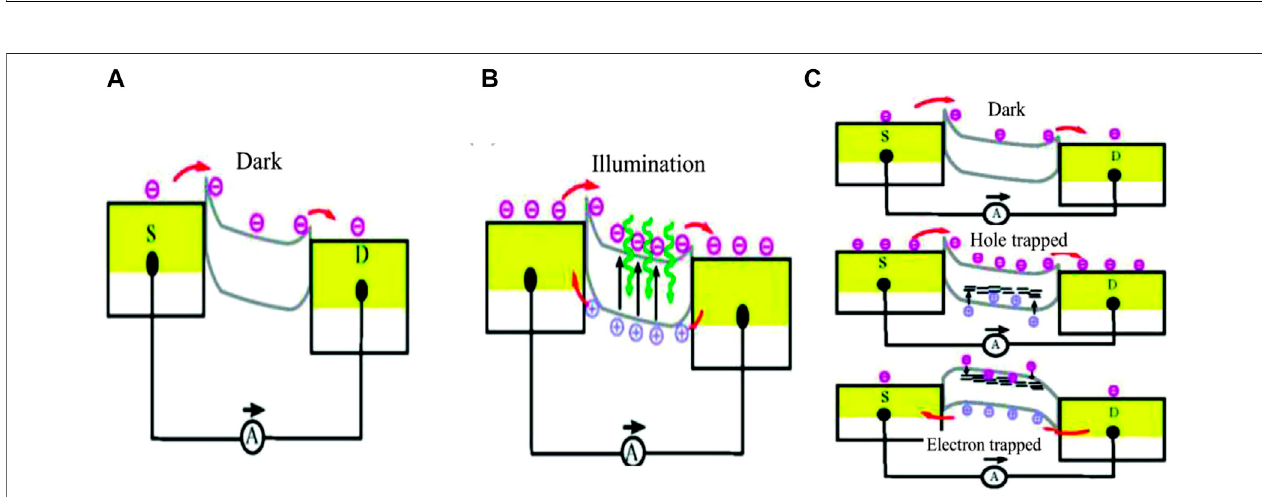
FIGURE 3 | Photodetection mechanisms, (A , B) Schematic of photoconductive effect (Long et al., 2019), and (C) Schematic of photogating effect (Long et al., 2019); Reproduced with permission from (Long et al., 2019).